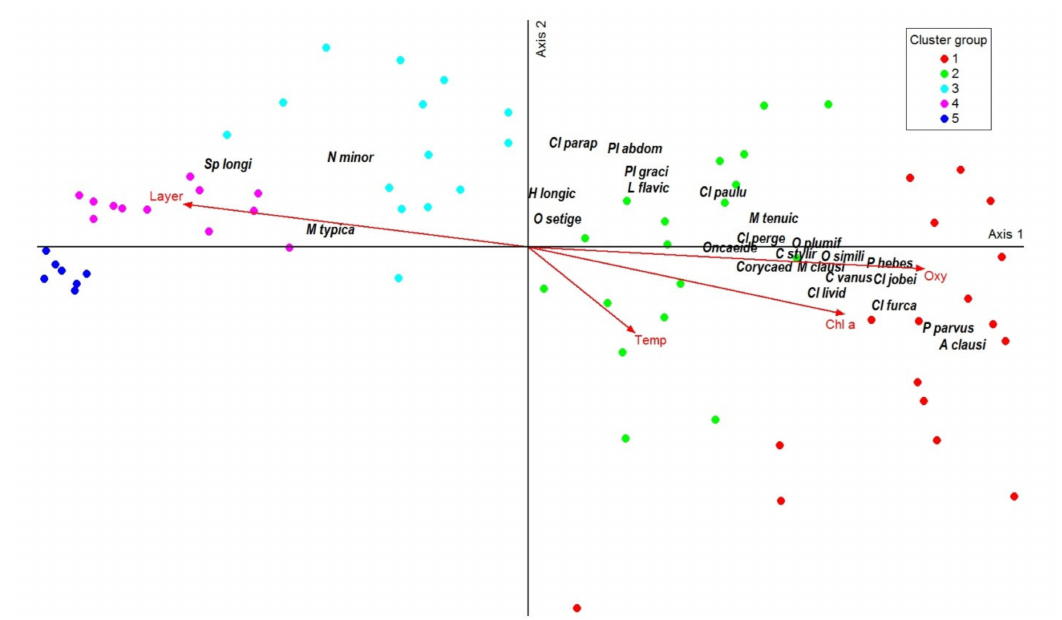
Figure 7. Ordination joint plot from the non-metric multidimensional scaling (NMS) with sample units labelled by cluster and position of the most abundant taxa with the environmental variables overlaid as vectors (Temp—Temperature, Chl- a , Oxy—DO, and Depth layer). Vector length and direction indicates relative strength of the correlation with axes. Abbreviation of